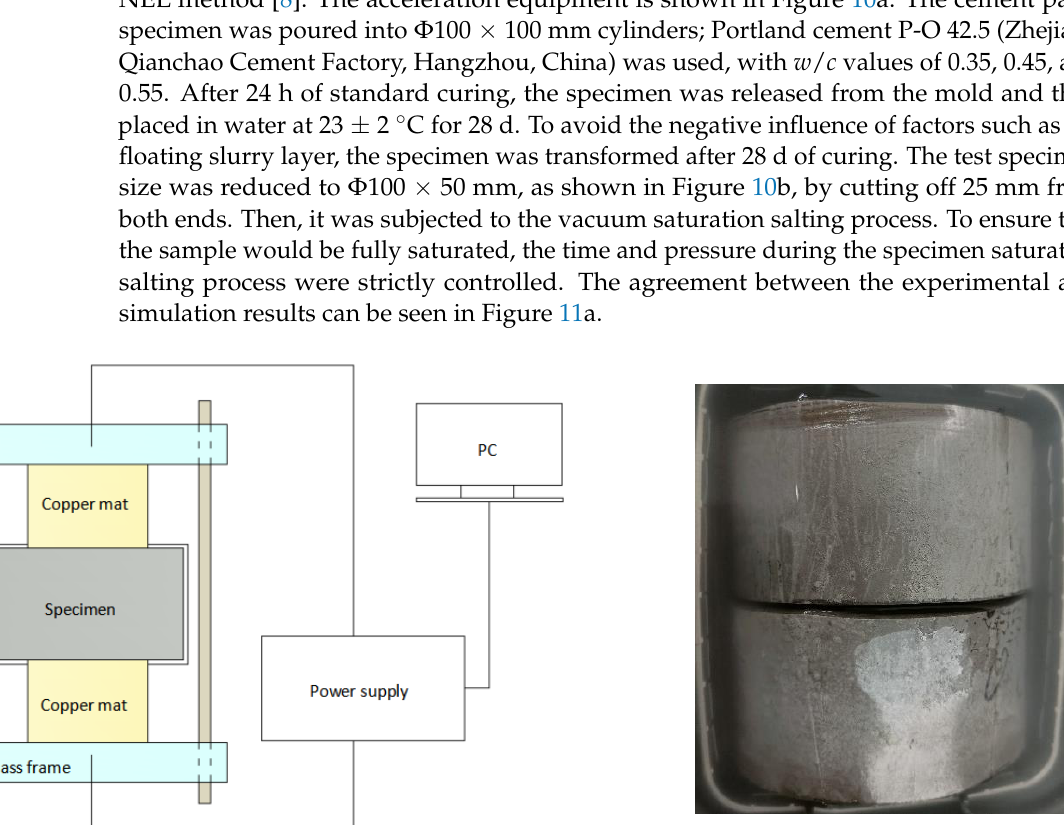
Figure 9. Determination of the values of M and R 0 .